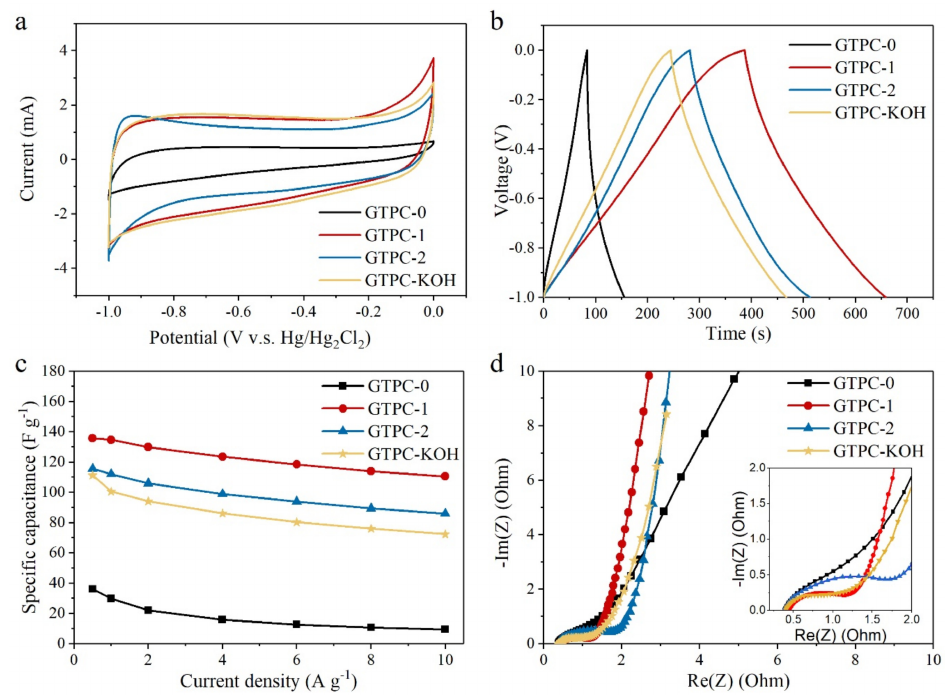
Figure 5. ( a ) Cyclic voltammetry (CV) curves of all of the GTPC samples at the scan rate of 5 mV s − 1 . ( b ) Charge–discharge curves of GTPC samples at the current density of 0.5 A g − 1 . ( c ) Specific capaci- tances of GTPC samples at different current densities. ( d ) Nyquist plots of all of the GTPC samples.